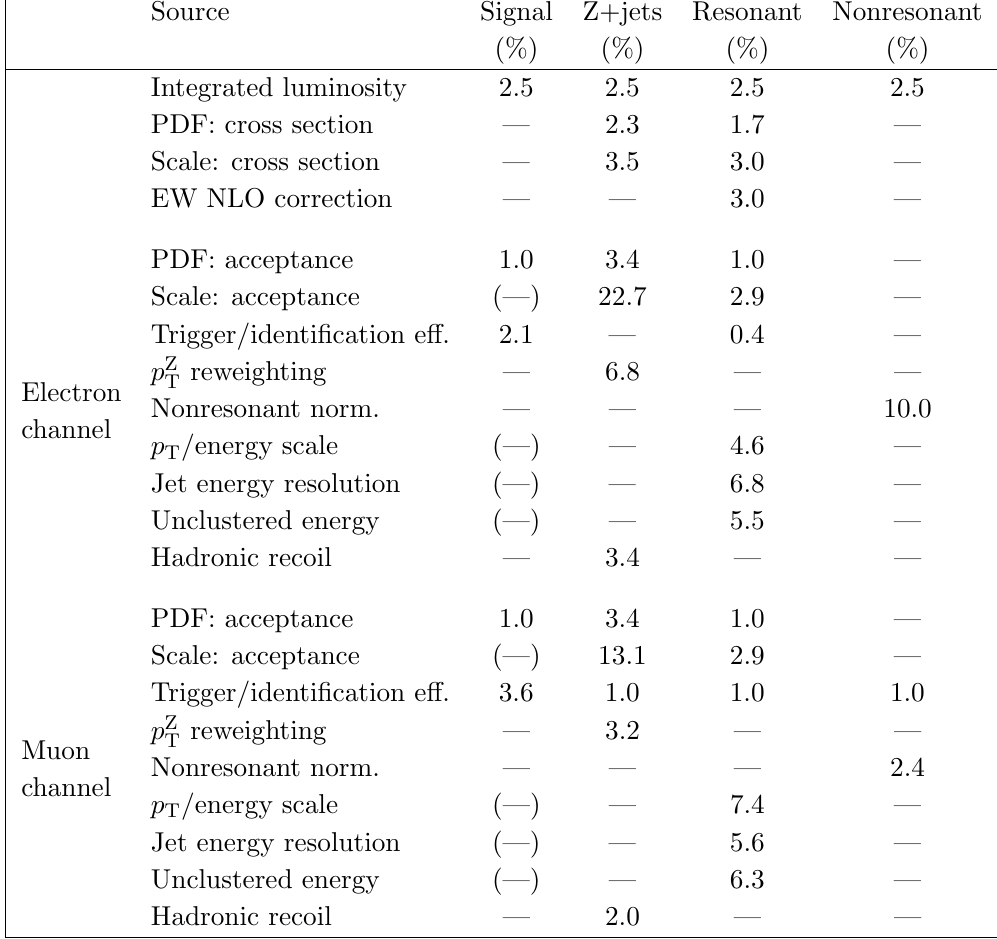
Table 1 . Summary of the normalization uncertainties that are included in the statistical proce- dure for the electron and muon channels. All values are listed in percentage units and similar categories are grouped for brevity. Sources that do not apply or are found to be negligibly small are marked \|" or \(|)," respectively. Integrated luminosity and theoretical uncertainties are evaluated separately for e(cid:11)ects on normalizations, while all the other uncertainties are considered simultaneously with shape variations in the statistical analysis. Values in the signal column refer to the hypothetical spin-2 bulk graviton signal with a mass of 1